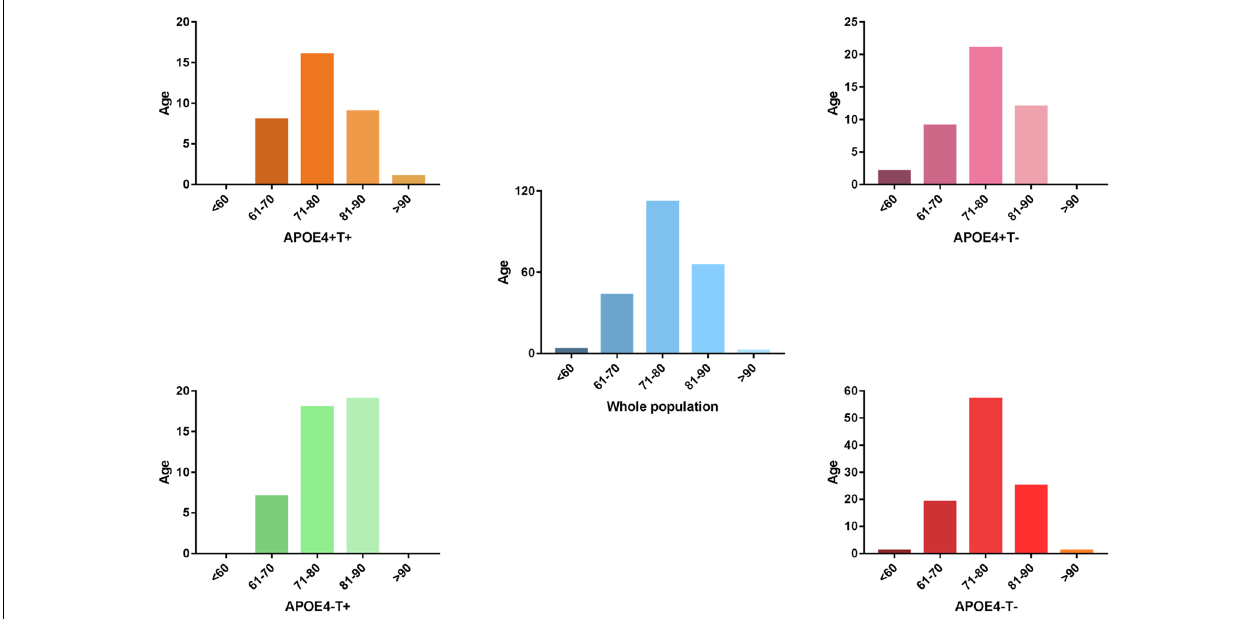
FIGURE 1 | The distribution of whole population. We performed statistics according to the age distribution of the all subjects (age < 60; 61 < age < 70; 71 < age < 80; 81 < age < 90; age > 90). Blue histogram represents the age distribution of all subjects. Orange, purple, green, red histogram represent the age distribution of APOE 4+T+, APOE 4+T − , APOE 4 − T+, APOE 4 − T − group, respectively.